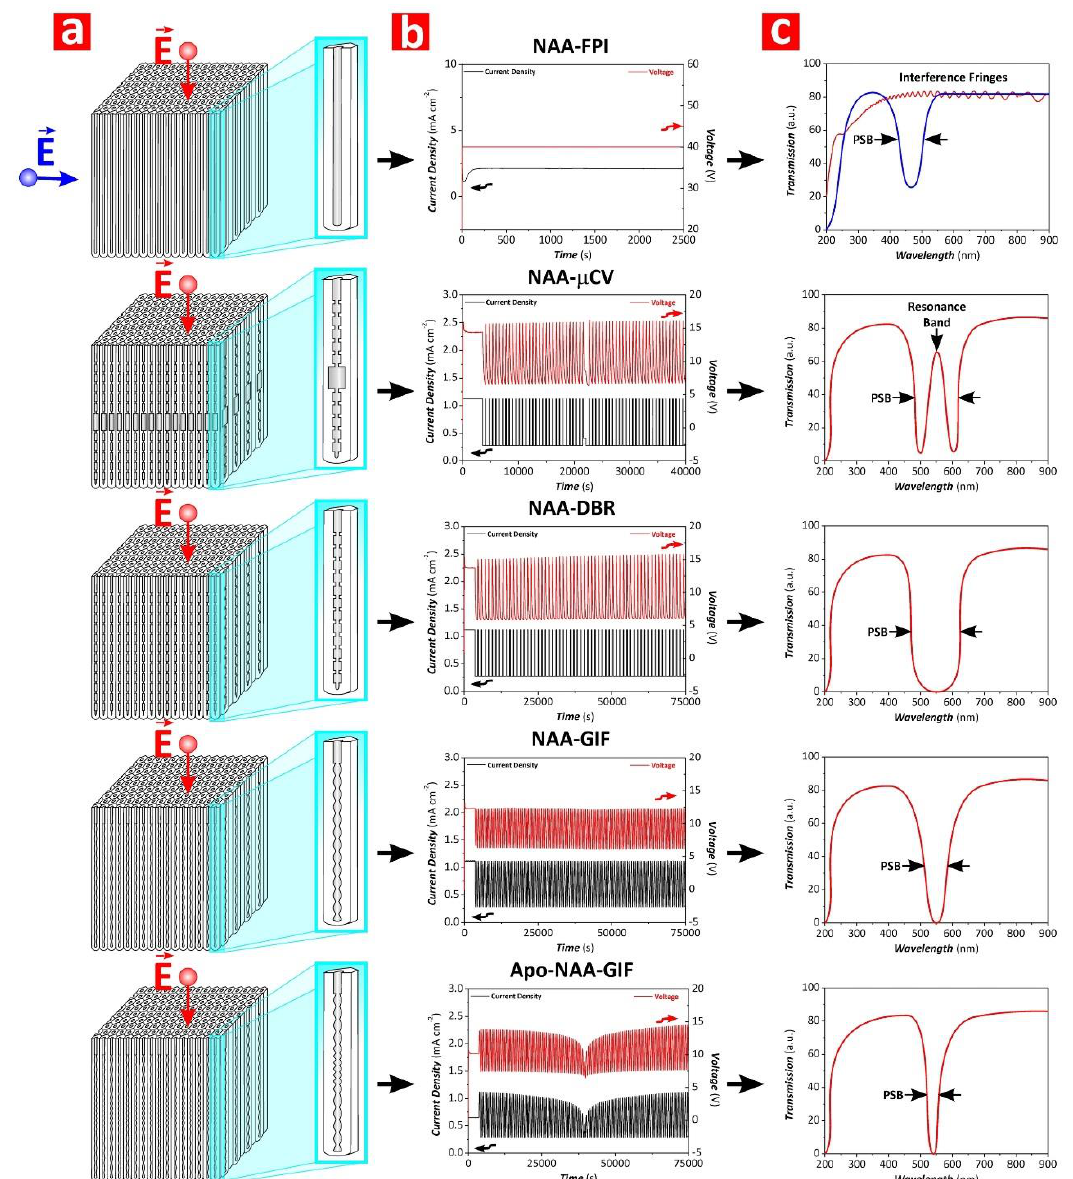
Figure 6. Characteristic nanoporous geometry, anodization profile, and optical properties of representative nanoporous anodic alumina photonic crystals (NAA-PCs) (from top to bottom: NAA-FPI—NAA Fabry–Pérot interferometer; NAA-μCV—NAA optical microcavity; NAA-DBR—NAA distributed Bragg reflector; NAA-GIF—NAA gradient-index filter; Apo-NAA-GIF—apodized NAA gradient-index filter). ( a ) Schematic showing details of the nanoporous structure of NAA-PCs where E indicates the direction of the electromagnetic field. ( b ) Representative experimental anodization profiles used to produce NAA-PCs. ( c ) Illustration of optical transmission spectra showing the characteristic photonic features of NAA-PCs.